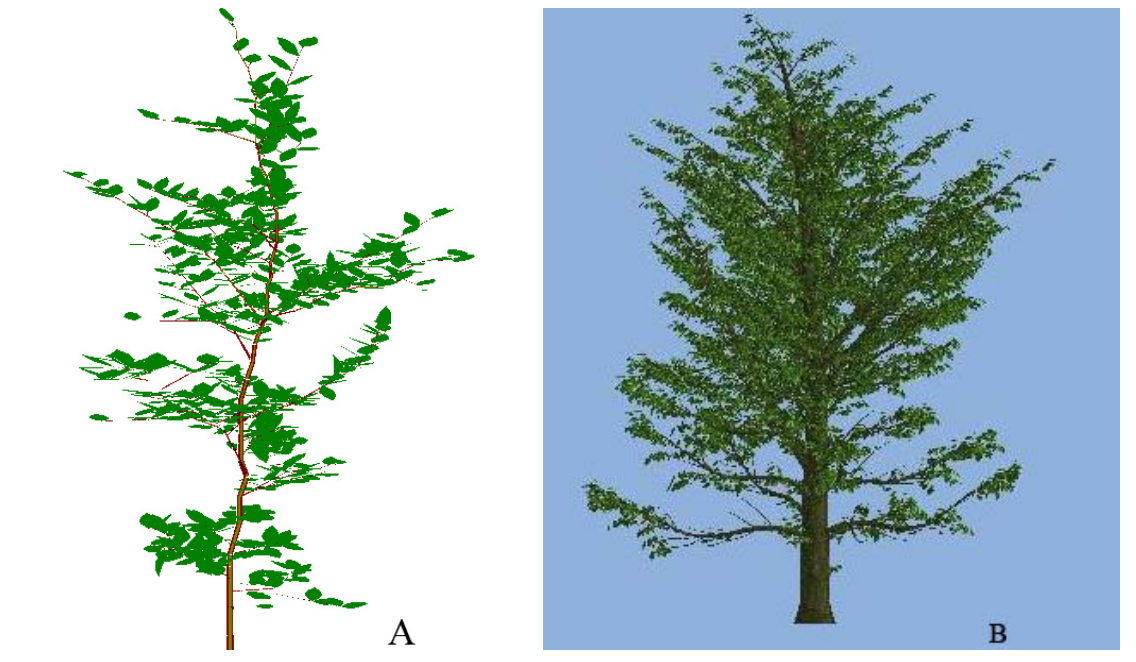
Figure 1. Trees used for explicit simulation of the Fagus sylvatica (L.) canopy. Left (A),